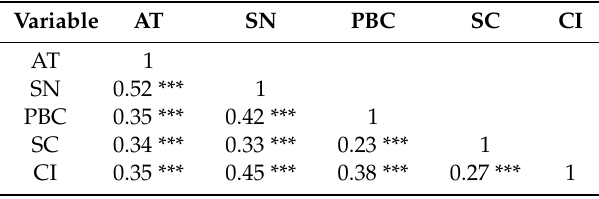
Table 3. Correlation analysis between the di ff erent variables.